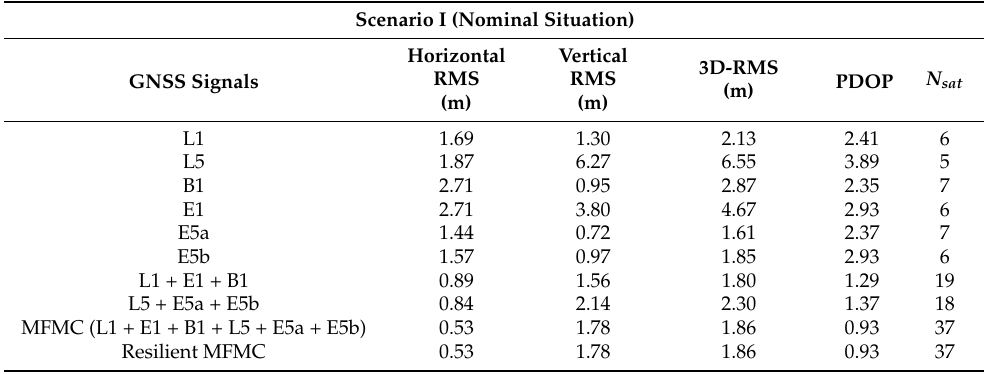
Table 4. Positioning accuracy of Scenario I with different signal combinations.